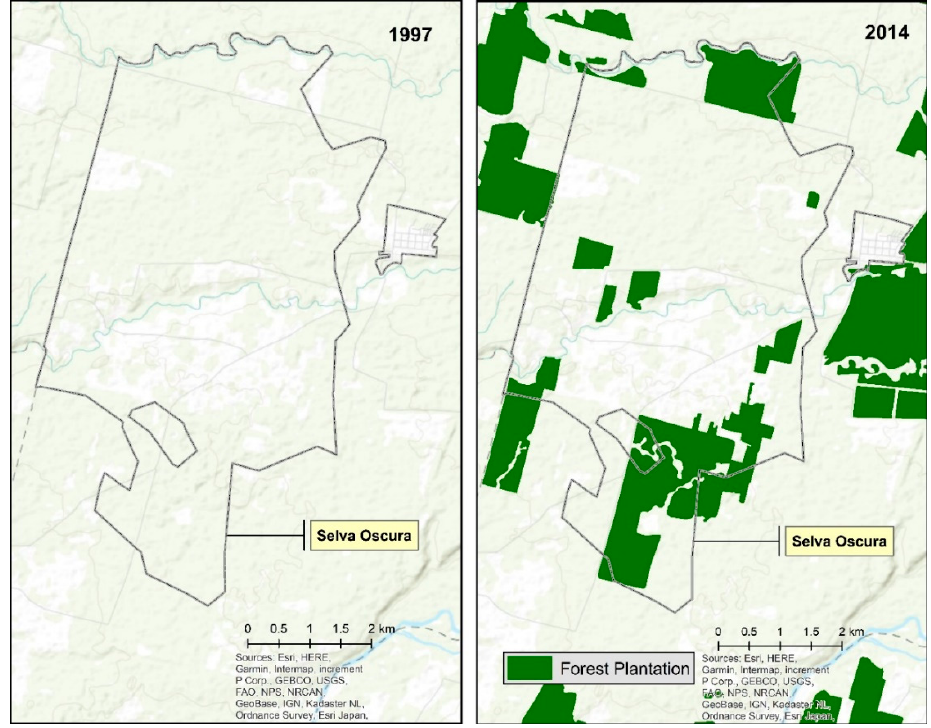
Figure 2. Forest plantations in and around Selva Oscura in 1997 ( left ) and 2014 ( right ). Forest plantation data source: CONAF, the Chilean National Forest Corporation. Created by Molly H. Polk.